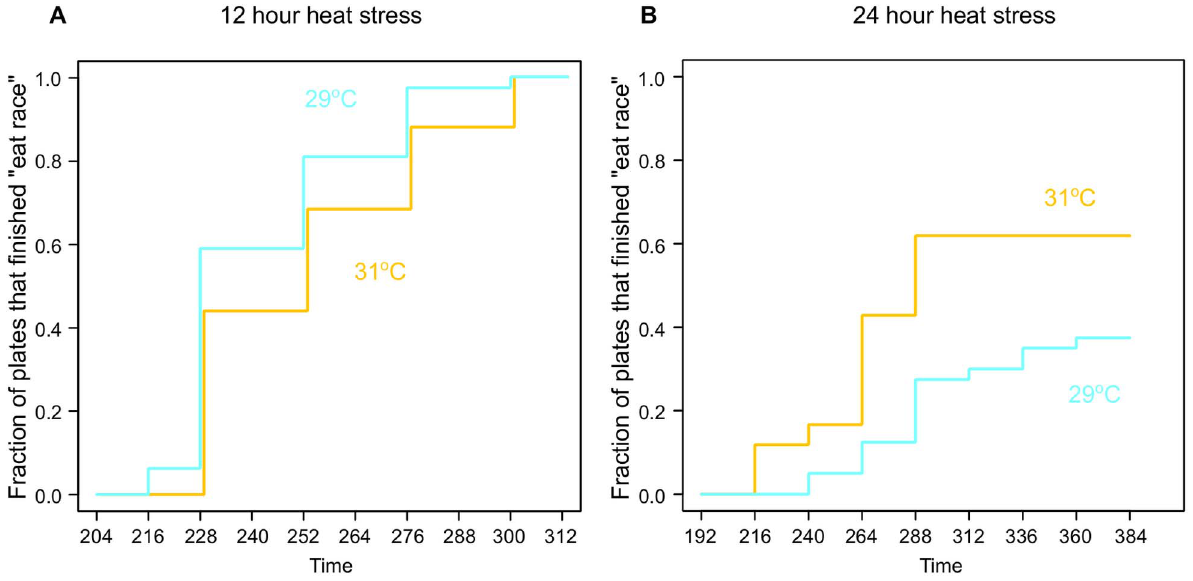
Figure 7. Duration of heat stress determines whether stopping or continuing reproduction is the advantageous strategy. Curves represent the fraction of plates (each containing offspring of a single stressed individual) that have exhausted bacterial food and thus finished the ‘‘eating race’’. Because all plates initially contained equal amounts of bacteria, plates that were consumed faster contained more offspring. Depending on the duration of the stress, (A) 12 and (B) 24 hours, winning strategies were continued reproduction (worms stressed at 29 u C continued to lay eggs) or cessation (worms stressed at 31 u C did not ovulate or lay eggs). Time is in hours. The difference between the two curves was suggestive, although not significant in panel A (Kolmogorov-Smirnov test p =0.13) and significant in panel B ( p =1.7 6 10 2 4